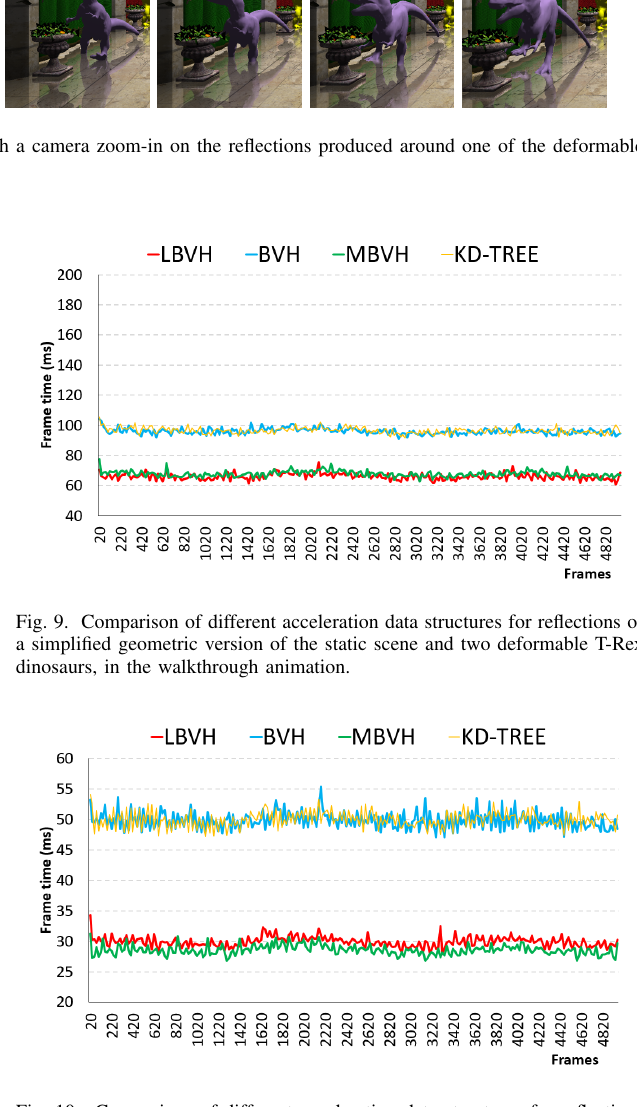
Fig. 10. Comparison of different acceleration data structures for reflections including only the two deformable T-Rex dinosaurs and ignoring all the rest of scene, in the walkthrough